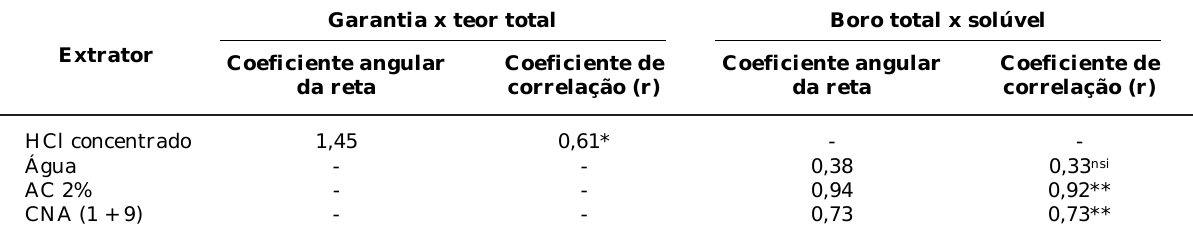
primas que não o